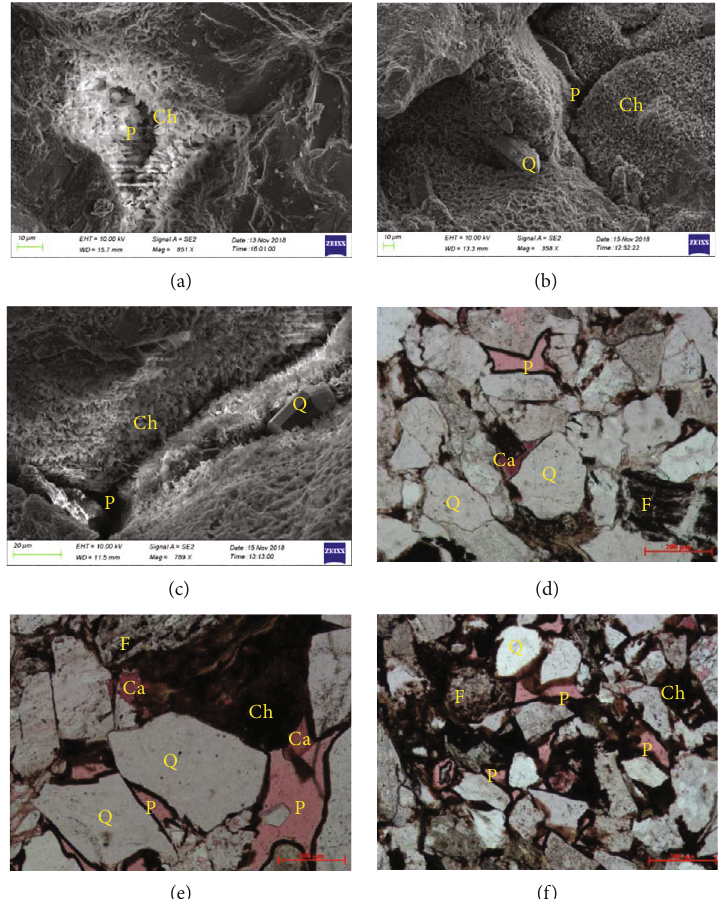
Figure 2: Typical pore types found in the tight oil sandstone samples. (a) Residual interparticle pores coated by chlorite (B280-13-3). (b) Chlorite and residual organic matter dominate the residual interparticle pores (B436-7-38). (c) Residual interparticle pores with feldspar dissolution (B455-2-46). (d) Interparticle pore and feldspar dissolved pores (B436-7-33). (e) Interparticle pore and calcite cementation, residual interparticle pores fi lled with adsorbed organic matter (B455-2-60). (f) The intergranular pore and feldspar dissolved pore fi lled with adsorbed organic matter (B456-6-6) (Q: quartz; F: feldspar; Ca: calcite; Ch: chlorite; P: